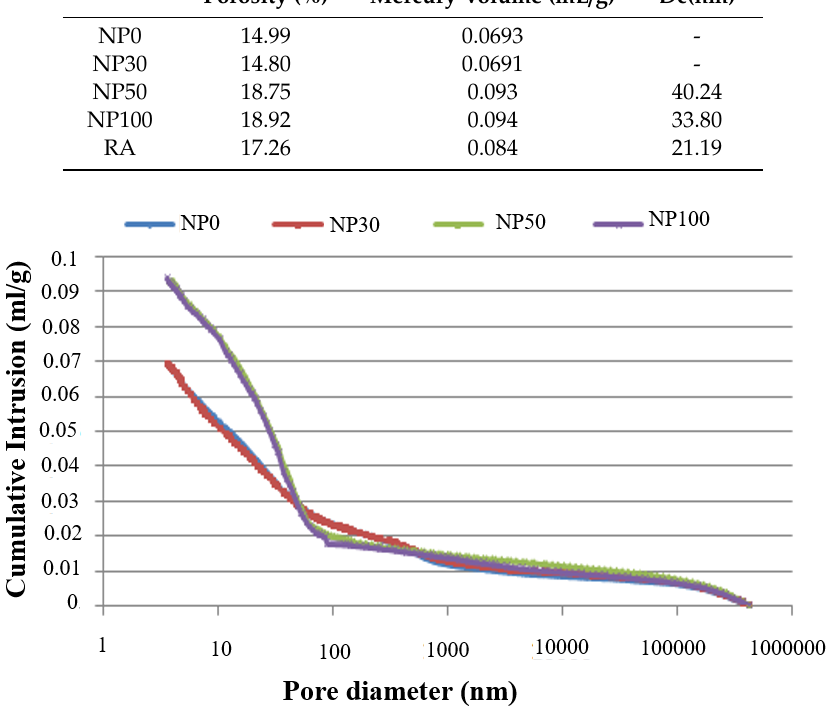
Figure 5. Cumulative intruded pore volume of new pastes (NP).